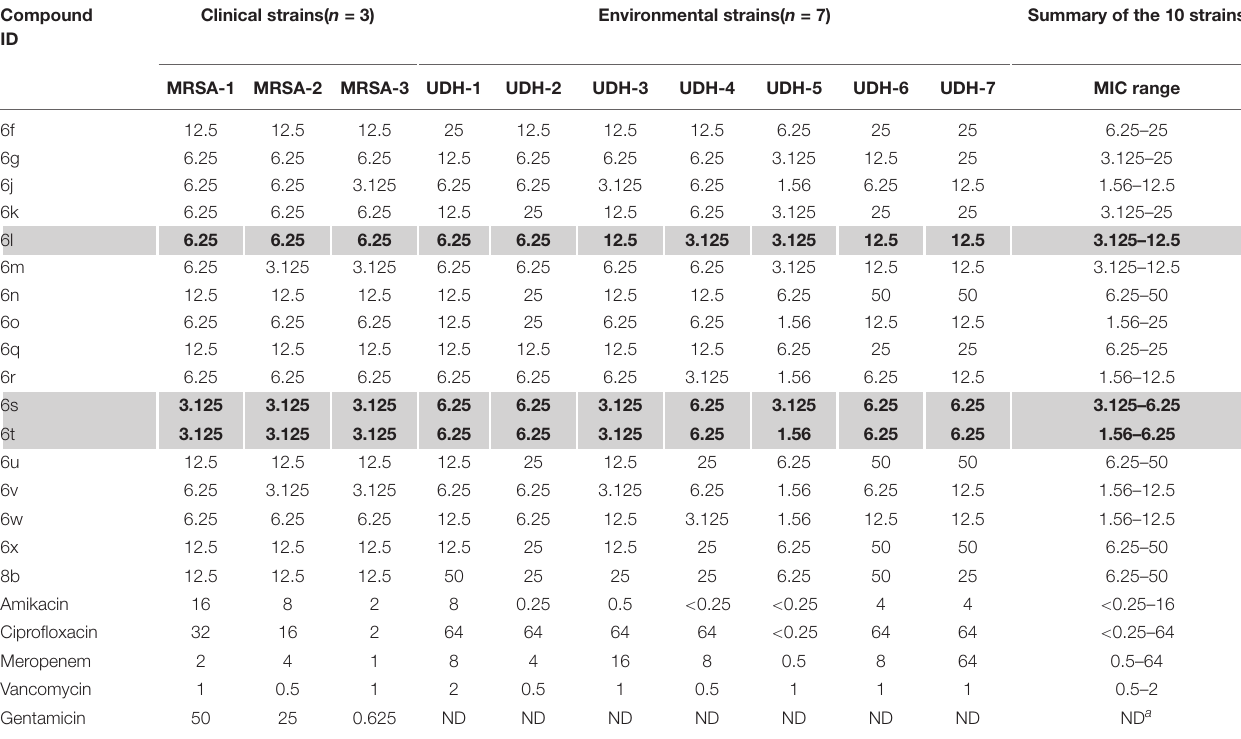
TABLE 1 | MICs ( µ g/ml) for compounds tested on 10 multidrug-resistant strains of the genus Staphylococcus . Compound Clinical strains( n = 3) ID